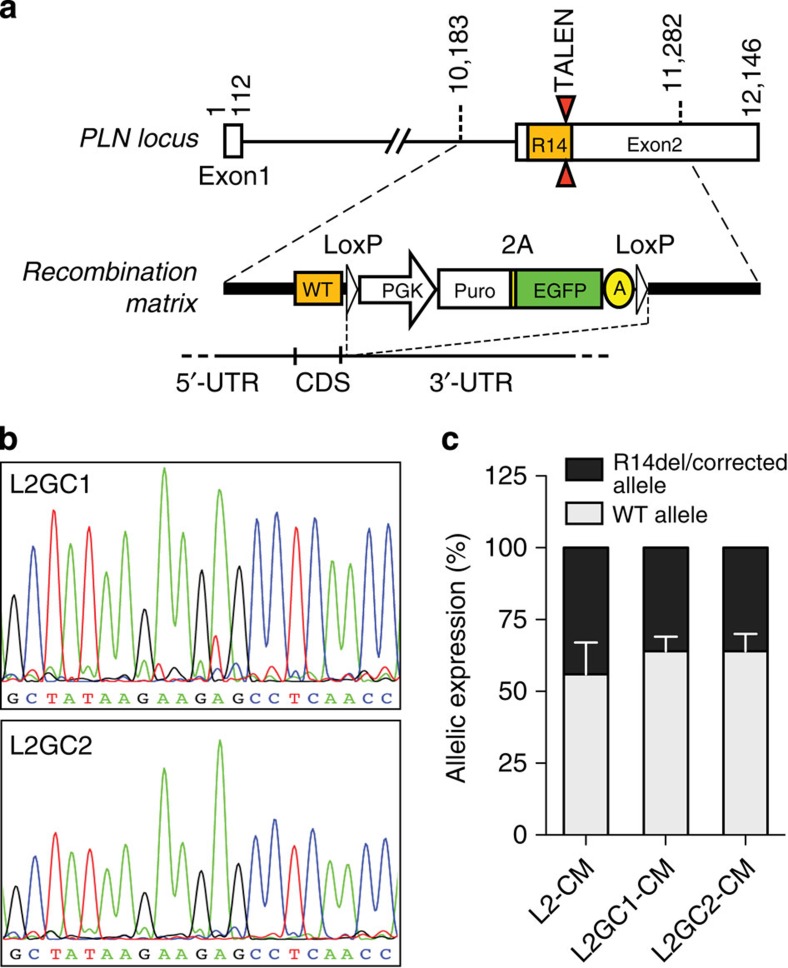
TALEN-mediated correction of R14del mutation.(a) Design of the exchange matrix to correct the R14del. (b) Confirmation by Sanger sequencing of the correction of the R14del mutation in two individual iPSCs clones derived from the L2 clone. (c) Pyrosequencing analysis of the PLN allelic expression in CMs derived from the parental and TALEN-corrected clones. Data represent mean±s.d. of three independent cardiomyocyte differentiations.